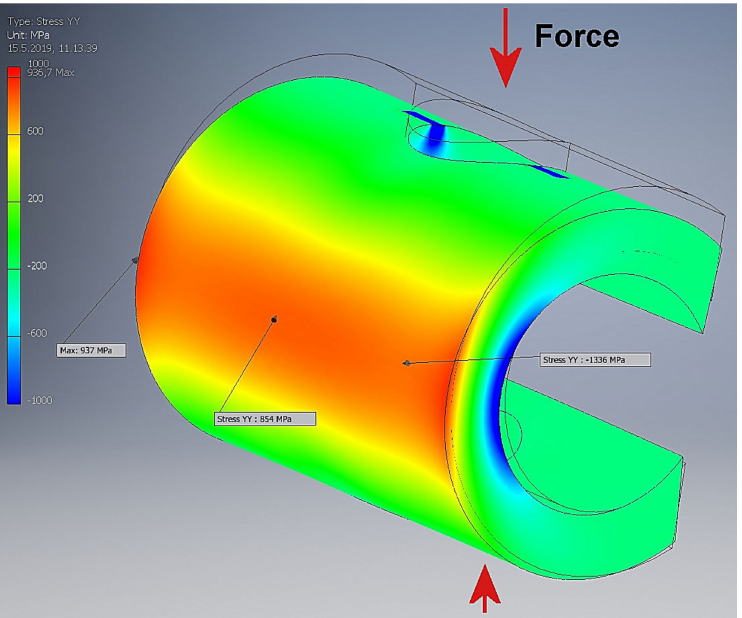
Figure 1. Schematically shown stress maximums in C-rings, where blue is compressive and red is tensile stress. (FEM analysis done by Autodesk Inventor Version